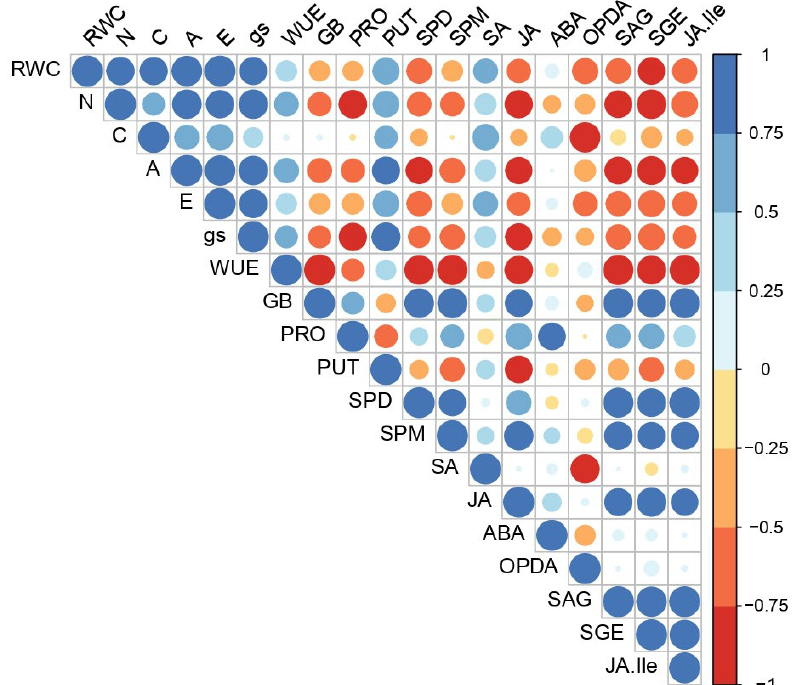
Figure 5. Pearson’s correlation matrix of analyzed physiological and biochemical parameters.